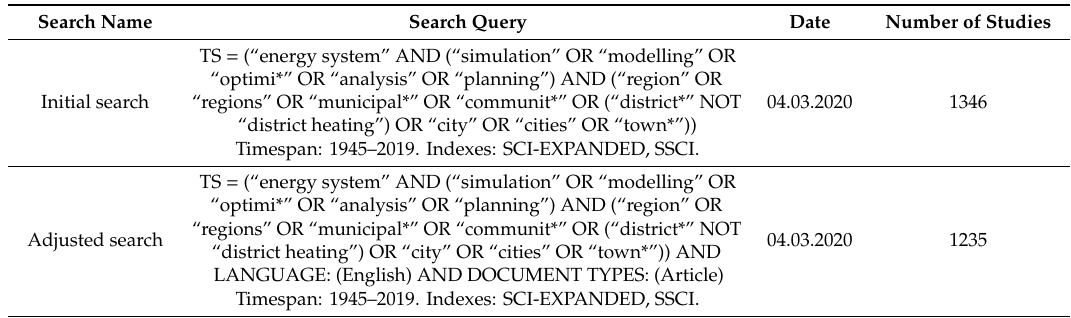
Table 1. Search queries and resulting number of articles in the literature database Web of